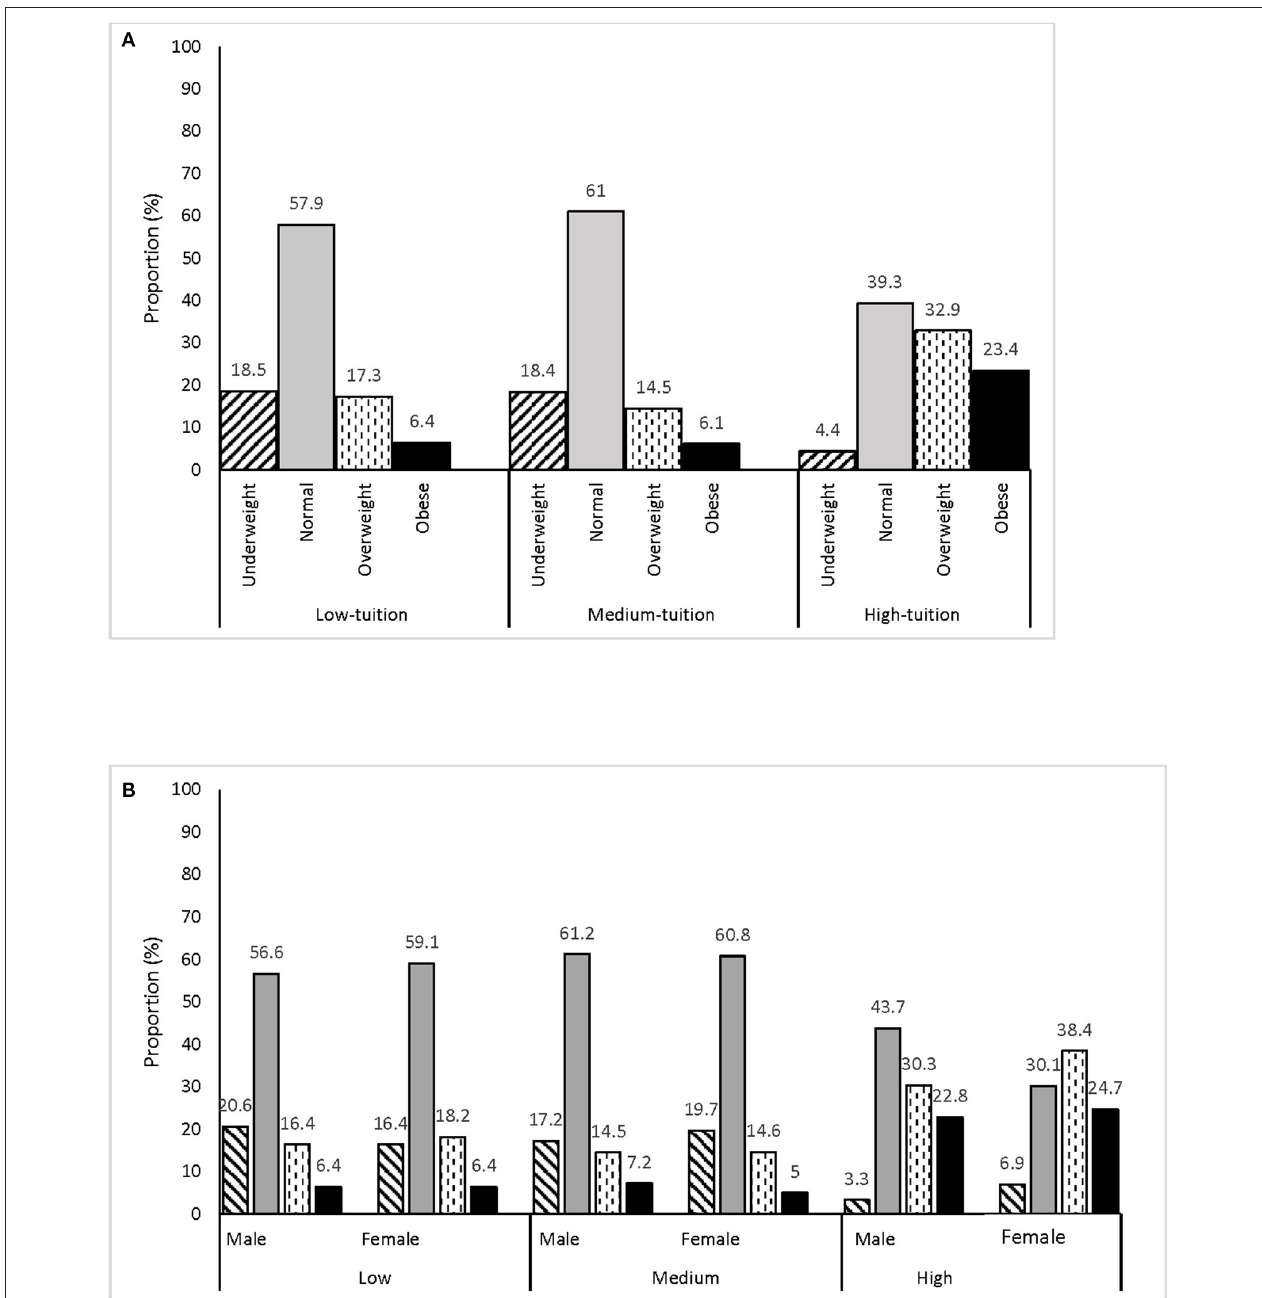
FIGURE 2 | Weight status among school children by school category (A) and gender (B)